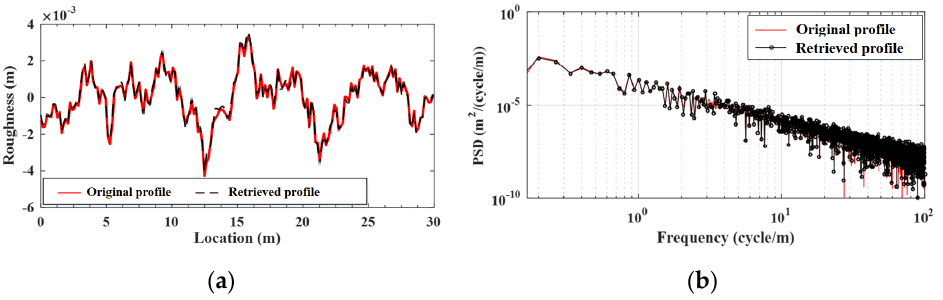
Figure 10. Retrieved and original surface profile (Class A roughness). ( a ) spatial domain; ( b ) frequency domain.